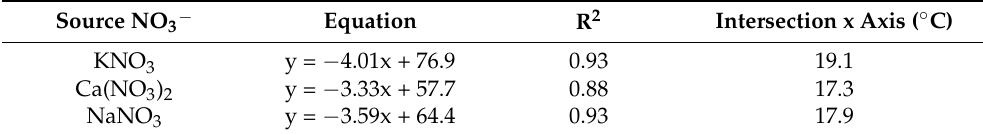
Table 3. Summary of linear regression equations, R 2 values, and the value of the intercept with the x-axis for the relationship of the relative difference between [NO 3 − ] measured with a ISE meter and the known [NO 3 − ], and sample temperature for each source of NO 3 − , in the sample temperature range of 5–25 °C. The measured [NO 3 − ] were the combined data sets from the two different ISE meters (LAQUAtwin models NO3-11 and B343). The known [NO 3 − ] were 6, 12 and 18 mmol L − 1 . In the regression equations, y is the percentage value of the deviation from the known value, i.e., ((measured [NO 3 − ] with ISE meter) minus (known [NO 3 − ]))/known [NO 3 − ] and x is sample temperature in ◦ C. Source NO 3 − Equation R 2 Intersection x Axis ( ◦ C) KNO 3 y = − 4.01x + 76.9